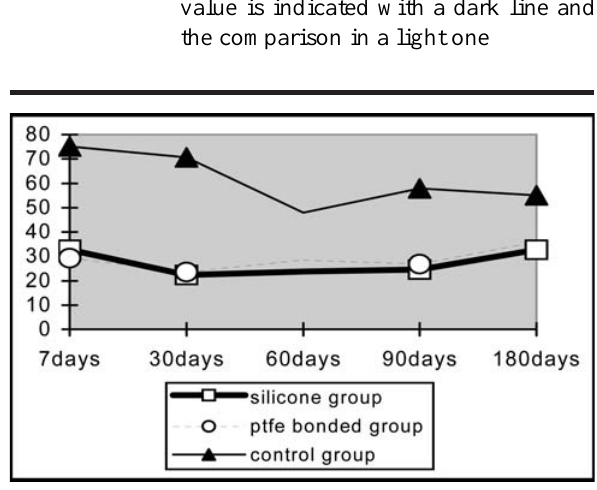
FIGURE 4 - Lynphocytes. Comparison among the silicone, bonded e-pfte and control groups separately in each subgroup (7, 30, 60, 90 and 180 days). The significant value is shown with a dark line and the comparison in a light